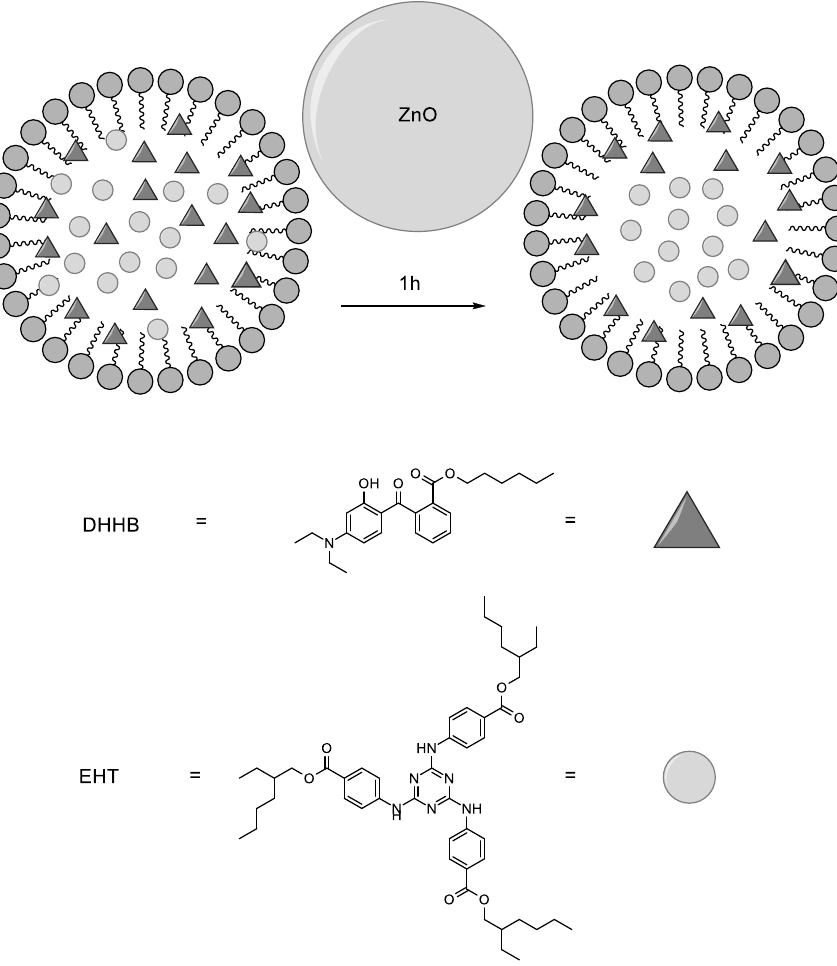
Figure 12. Proposed mechanism to explain the difference in the degradation of filters over 24 h.